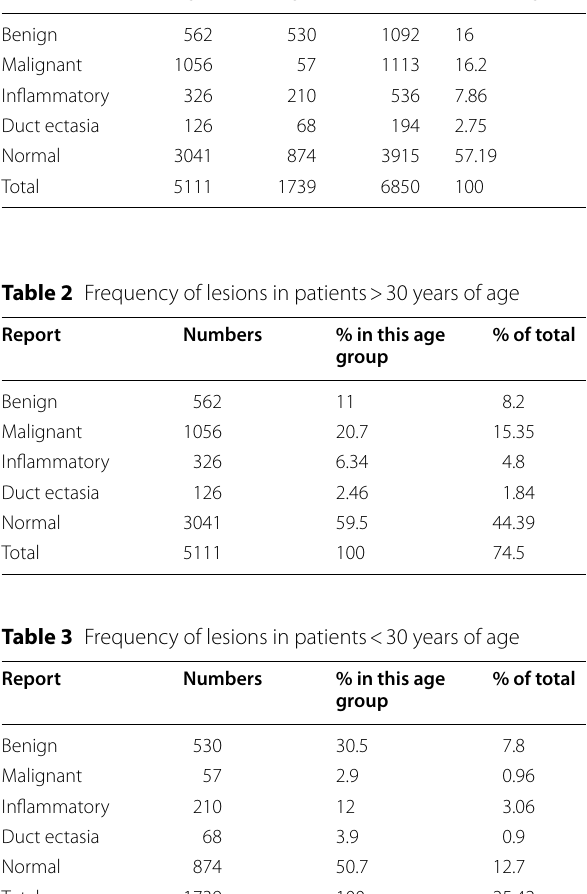
Table 1 Overall prevalence of different breast lesions in all ages Pattern of lesion